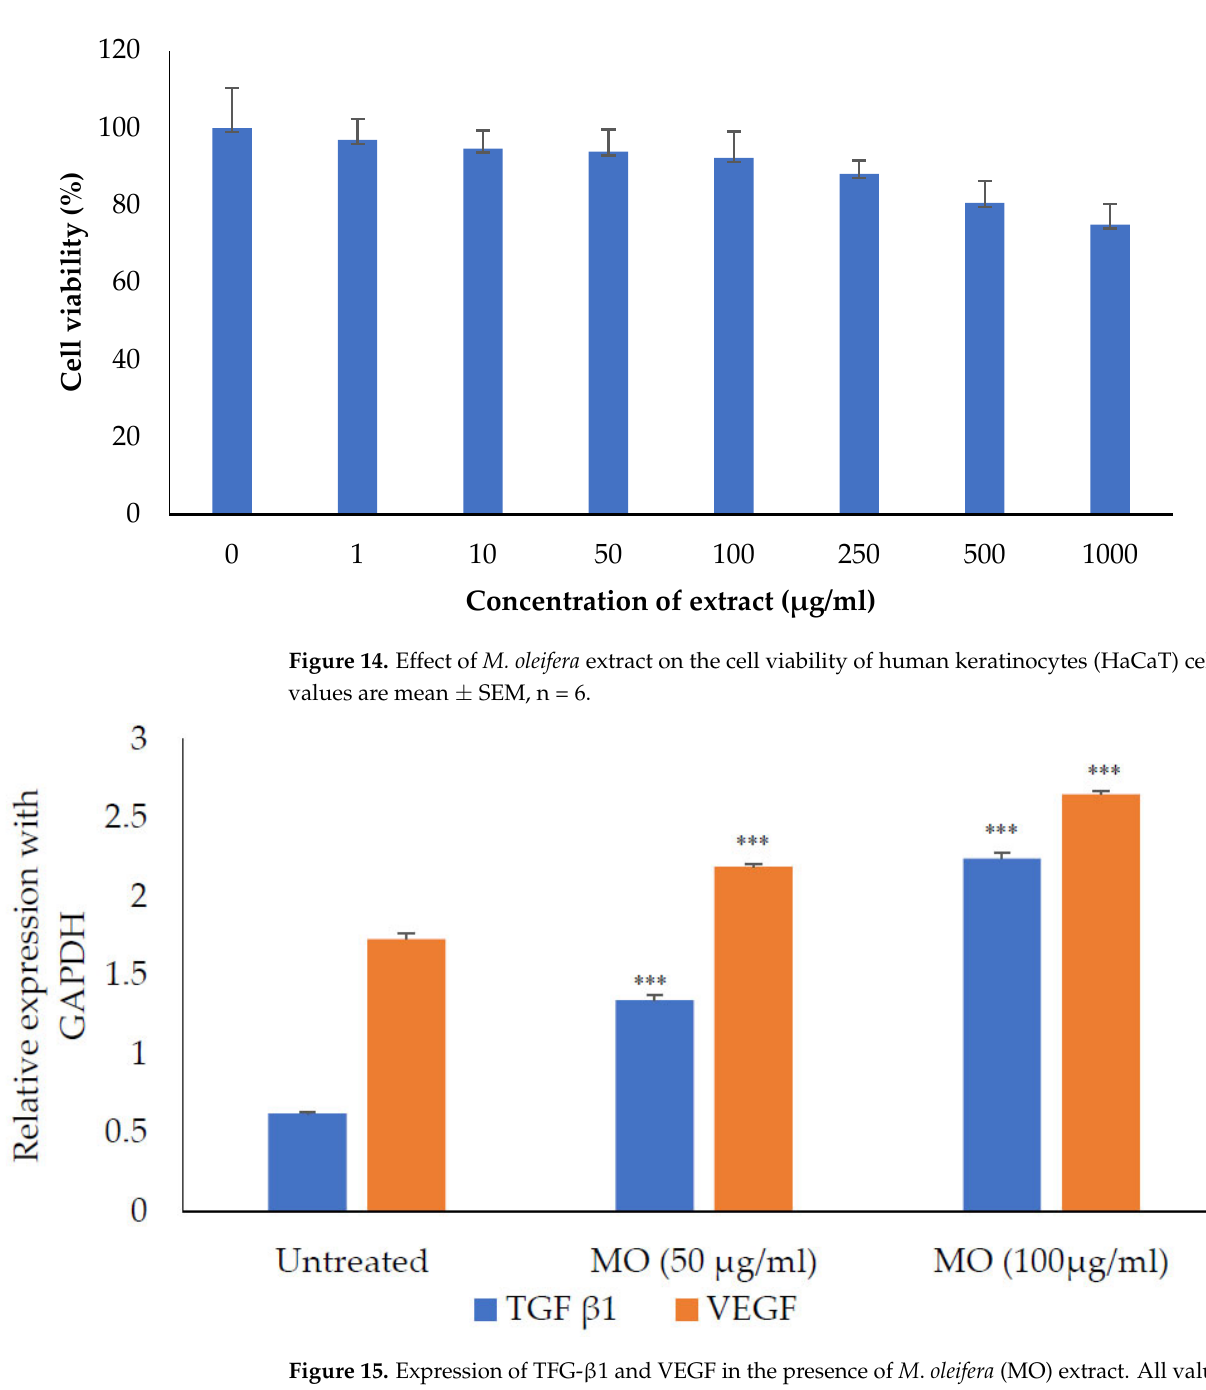
Figure 15. Expression of TFG ‐β 1 and VEGF in the presence of M . oleifera (MO) extract. All values are mean ± SEM, n = 6, *** p < 0.001 when compared to untreated cells.